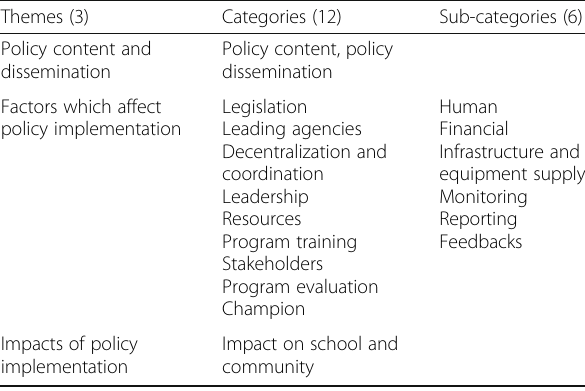
Table 2 Themes, categories, and sub-categories